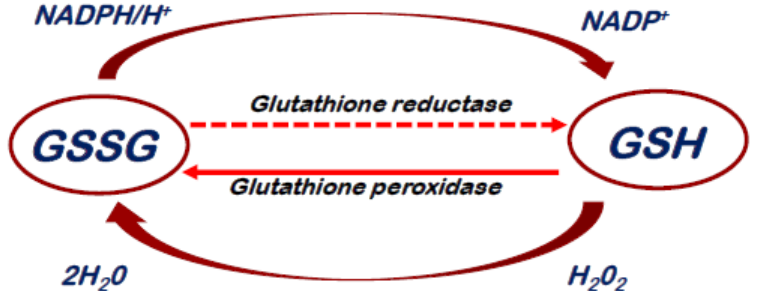
Figure 2. Glutathione Redox cycle. Abbreviations. GSSG: Oxidized Glutathione, GSH: Reduced Glu- tathione.